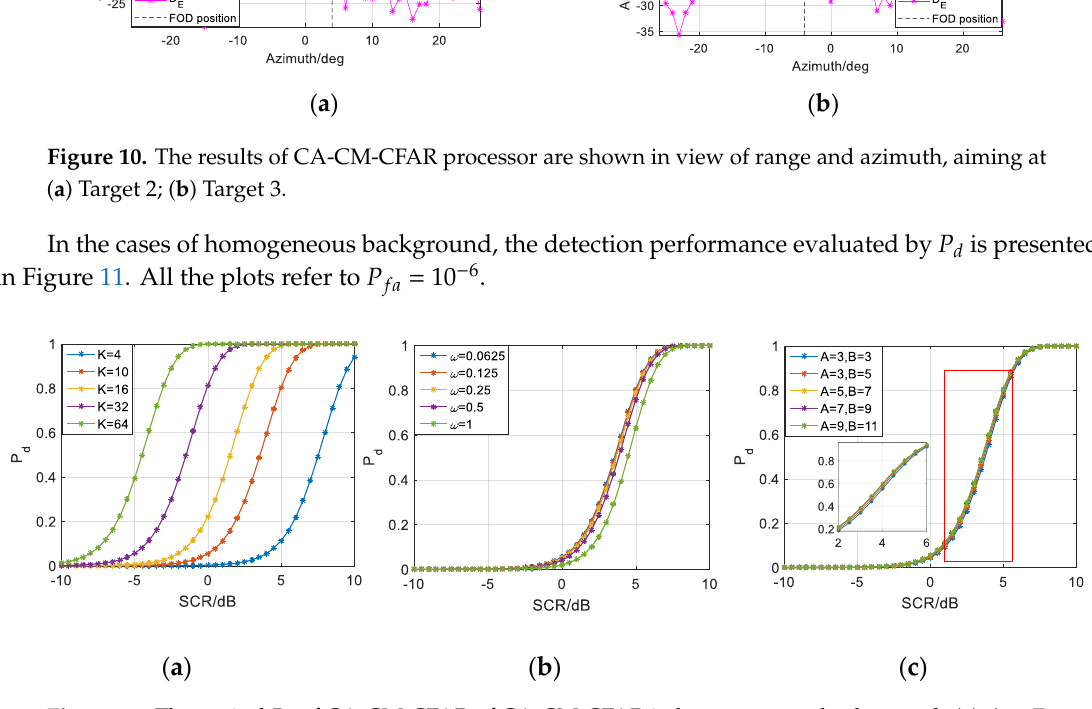
0.0625 ; ( b ) 𝐴 = 7 , 𝐵 = 9, 𝐾 = 10 ; ( c ) 𝜔 = 0.0625 and 𝐾 = 10 . B = 9, ω = 0.0625; ( b ) A = 7, B = 9, K = 10; ( c ) ω = 0.0625 and K = 10.